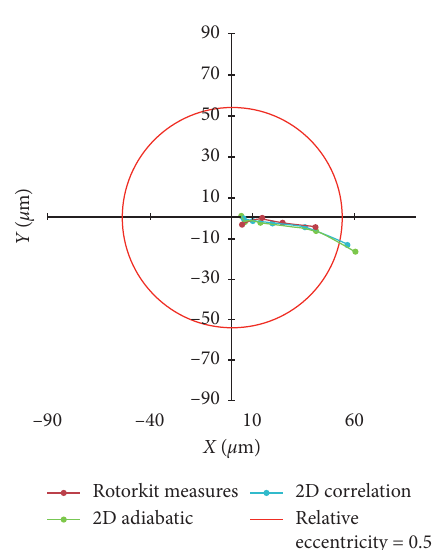
Figure 10: Journal center locations for the modified RK in con- figuration